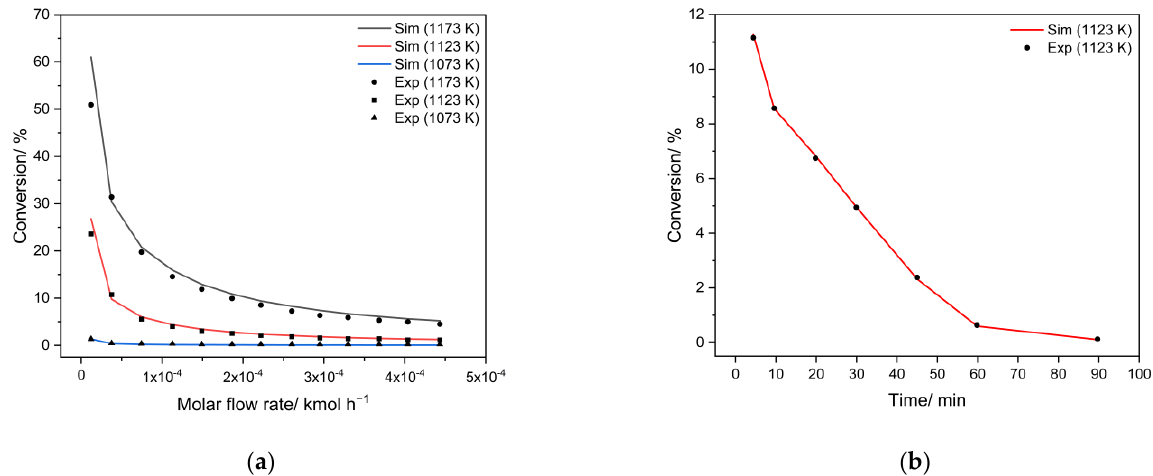
Figure 2. Results of kinetic validation for ( a ) thermal methane pyrolysis (TMP) and ( b ) catalytic methane pyrolysis (CMP) reactions.